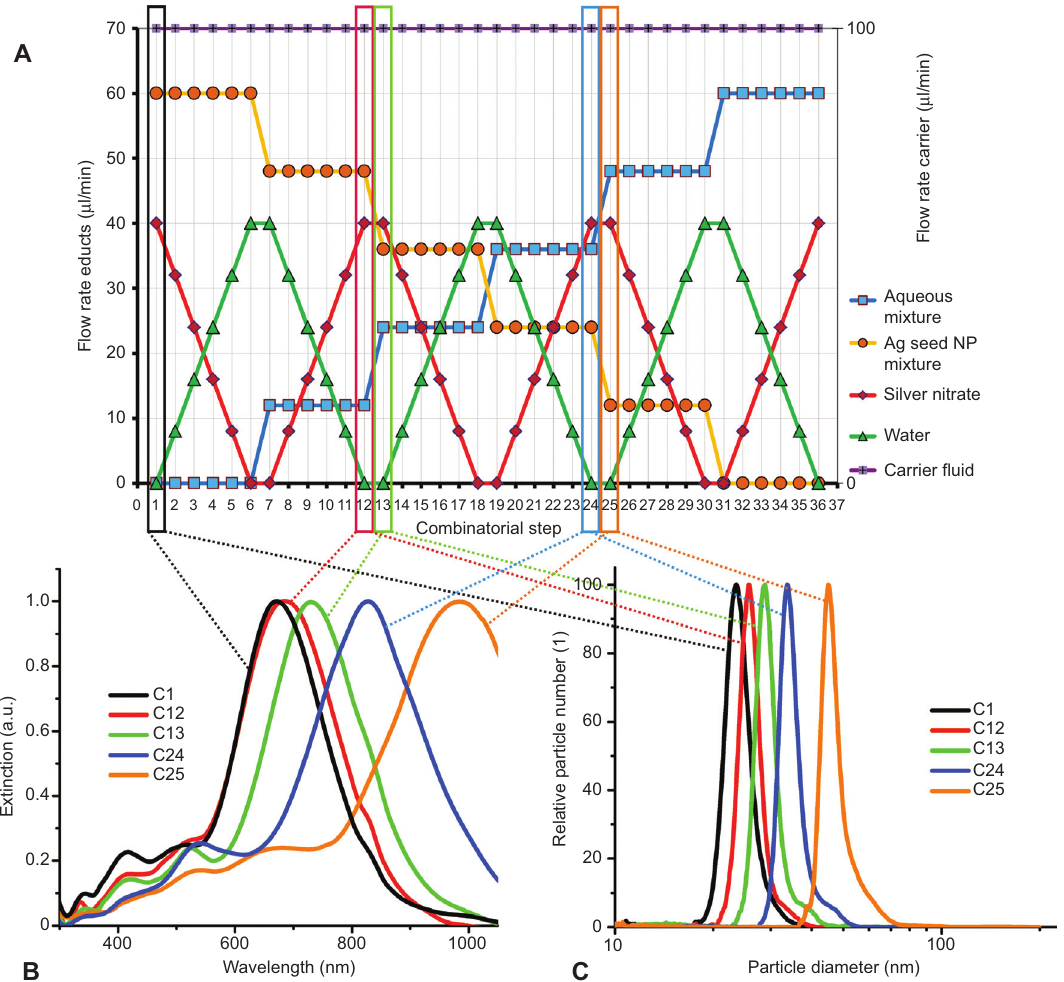
Figure 10 (A) Linear-linear flow rate run for the combinatorial synthesis of triangular silver nanoprisms. (B) UV-Vis spectra for conditions = 1 mm) and in steps of 20% decreasing silver seed nanoparticle density. A red shift of of constant maximum addition of silver salt (c(AgNO 3 the main dipole resonance wavelength occurs with decreasing seed particle concentration due to an increasing lateral expansion. (C) The corresponding DCS size distribution spectra clearly demonstrate an increasing particle